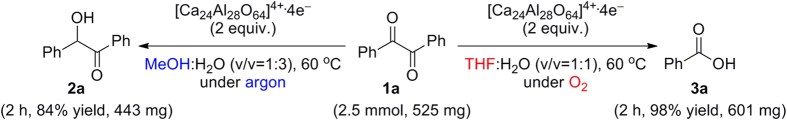
Large-scale production of 2a and 3a using the [Ca24Al28O64]4+∙4e− electride.